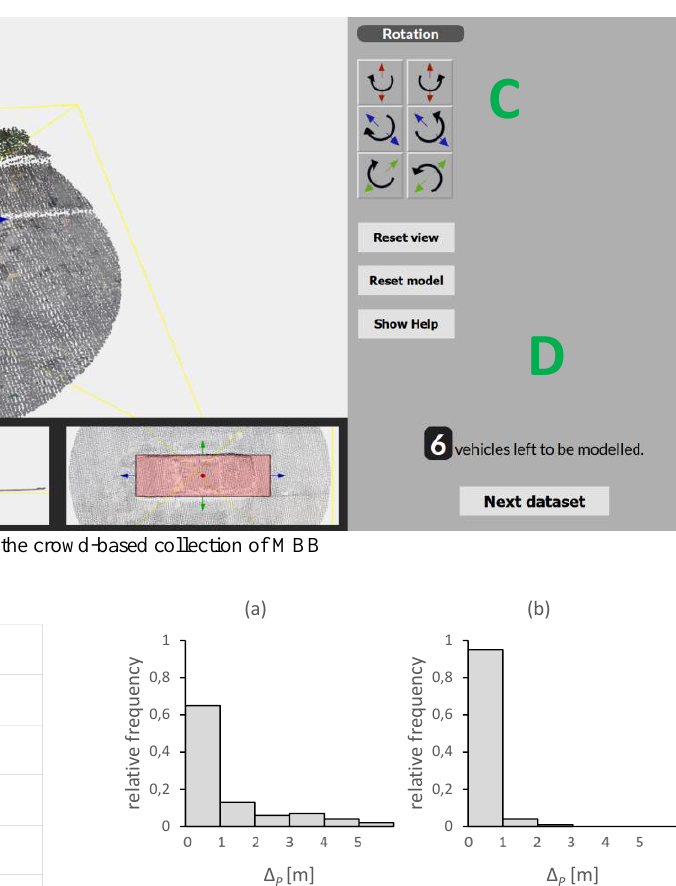
Figure 10. Position difference Δ P between crowdsourced and reference MBBs: (a) before outlier detection and integration, (b) after outlier detection and integration